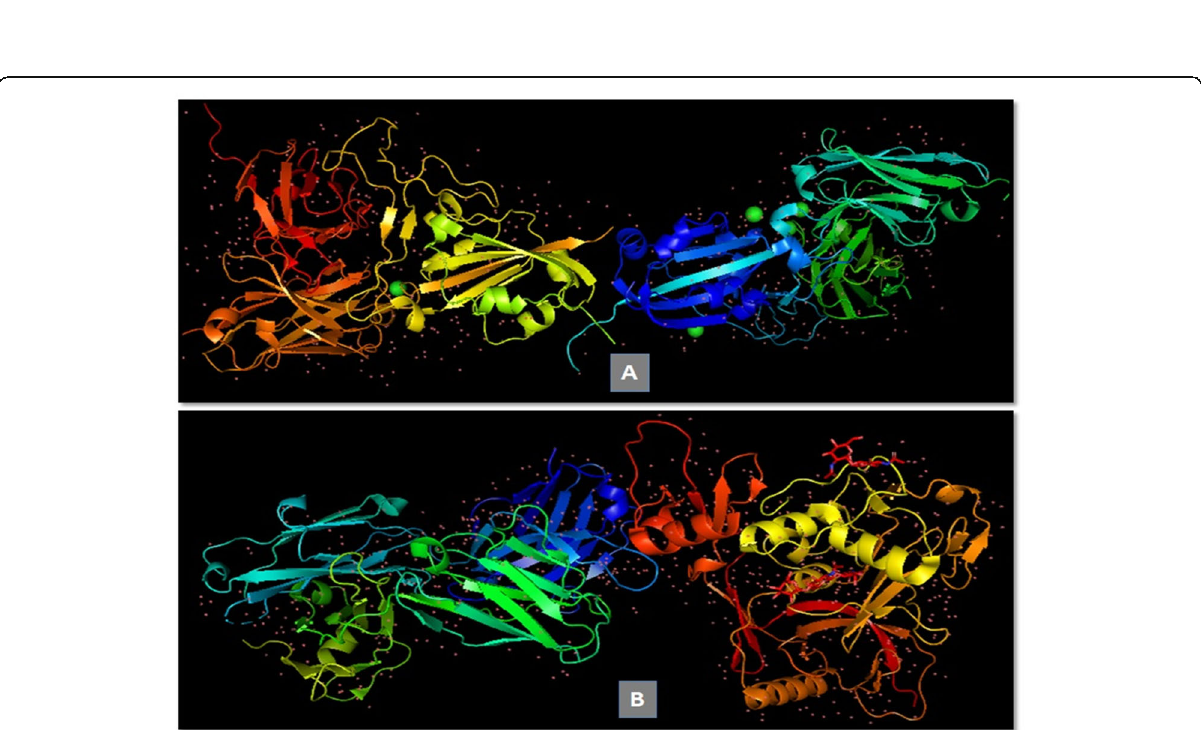
Fig. 3 Structure of proteins. a Spike protein of SARS-CoV2. b Membrane glycoprotein polyprotein of SFTS